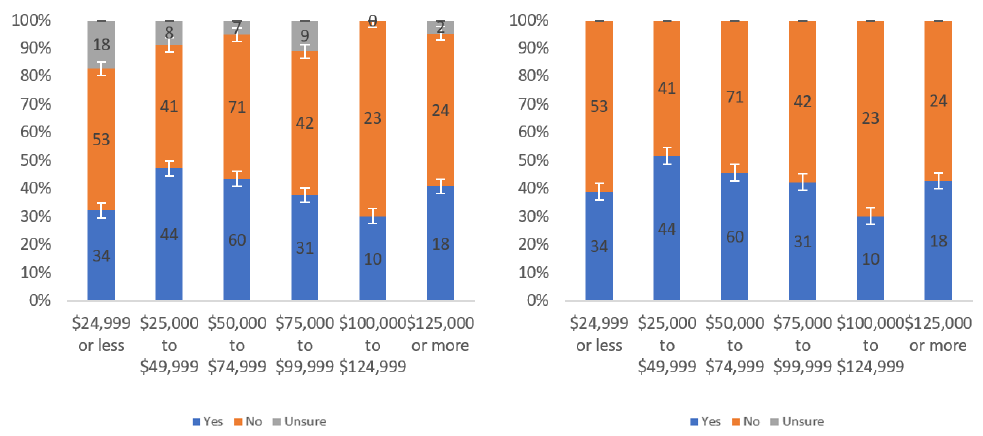
Figure 10. Responses regarding label annoyingness by income level including ( left ) and excluding ( right ) unsure responses.